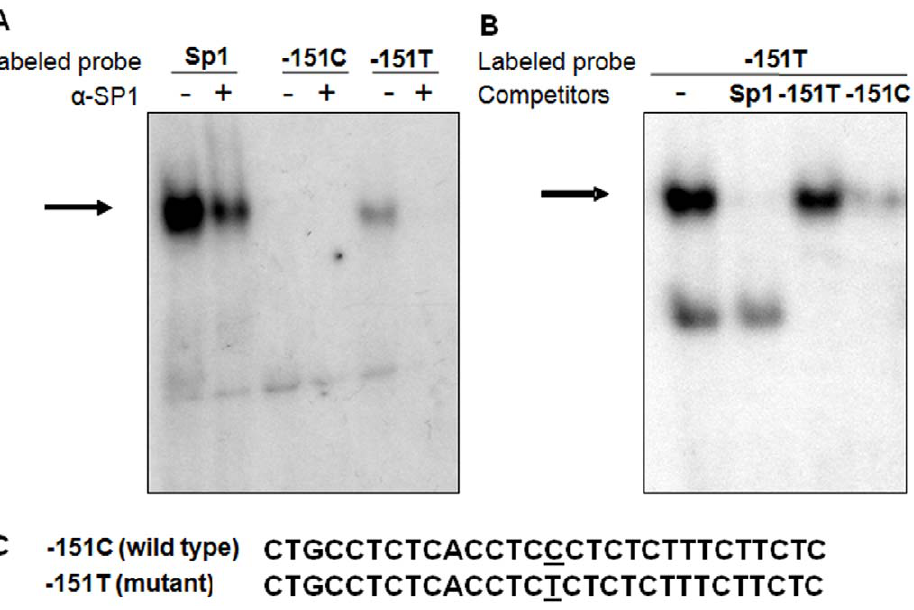
Figure 4. Effect of the GHSR -151T variant on the affinity of the Sp1-binding site by EMSAs. GH4 nuclear extracts incubated with labeled oligonucleotide probes containing an SP1 consensus site, the wild type GHSR -151C sequence, or the mutated GHSR –151T sequence. A: anti SP1 antibody ( a -SP1) was added to the reaction mix. B: binding to the –151T probe was competed with 200-fold molar excess of indicated unlabeled competitor probes. An arrow points to the complex exhibiting sequence-selective binding to the –151T probe. C : Sequences of wild type and mutant